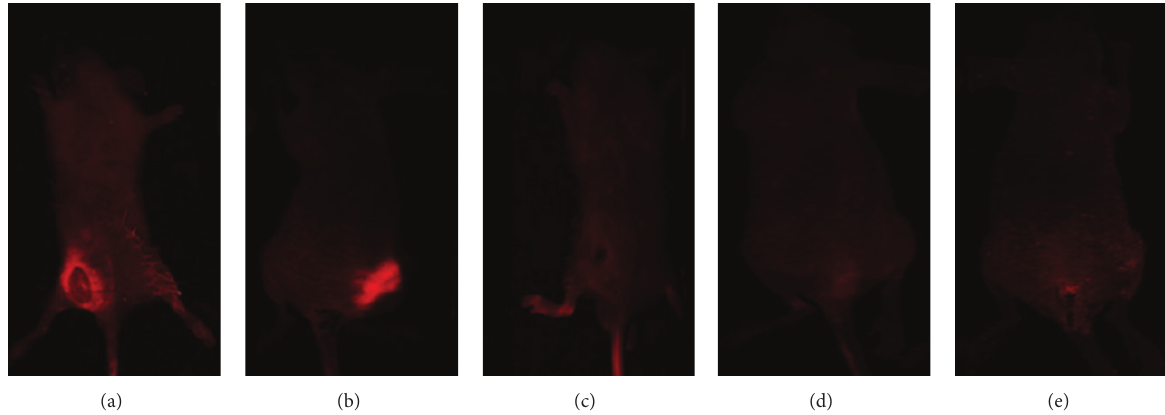
Figure 3: Tracing of fluorescently labeled drugs in vivo. (a) (RGD) 3 -tTF; (b) RGD; (c) TF; (d) normal mice injected with (RGD) 3 -tTF; (e)